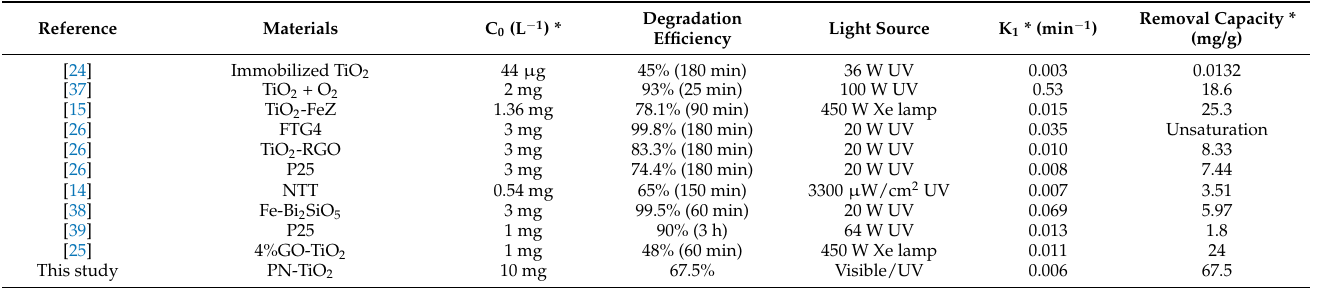
Table 1. Comparison of degradation efficiency and removal capacity of this study with the